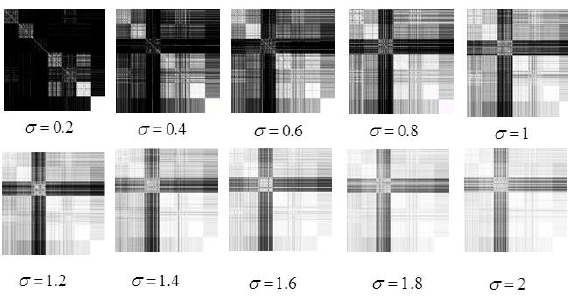
Figure 1. Multiscale kernel matrices for training samples of Bayview Park data